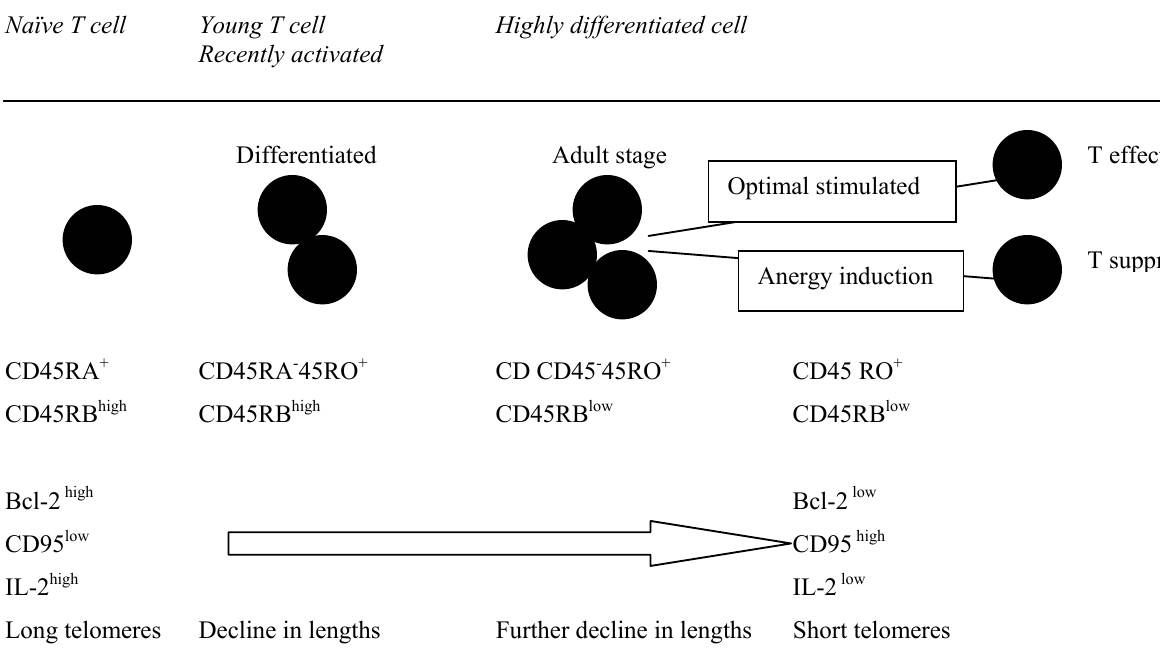
Table 2: Tolerance Induction in CD4 + CD25 + regulatory T cells. Naïve T